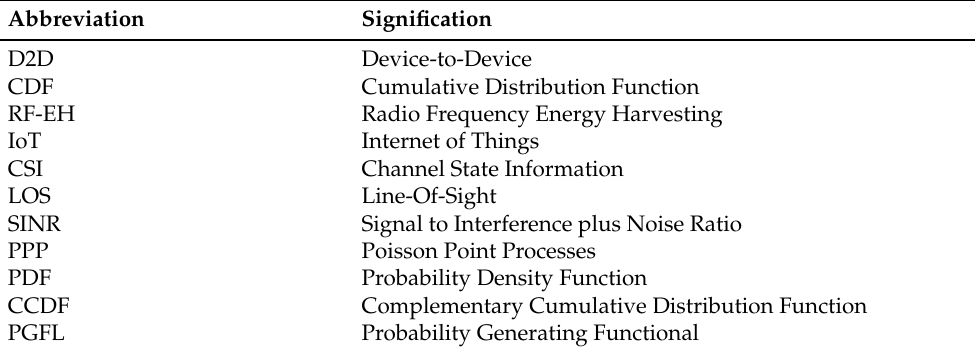
Table 2. List of